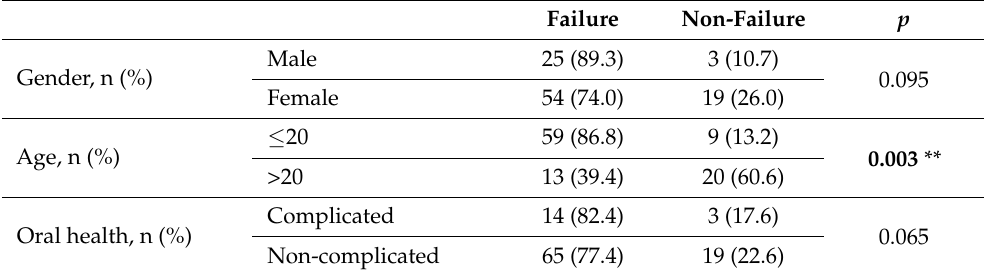
Table 3. Comparison of bond failures among gender, age and oral health